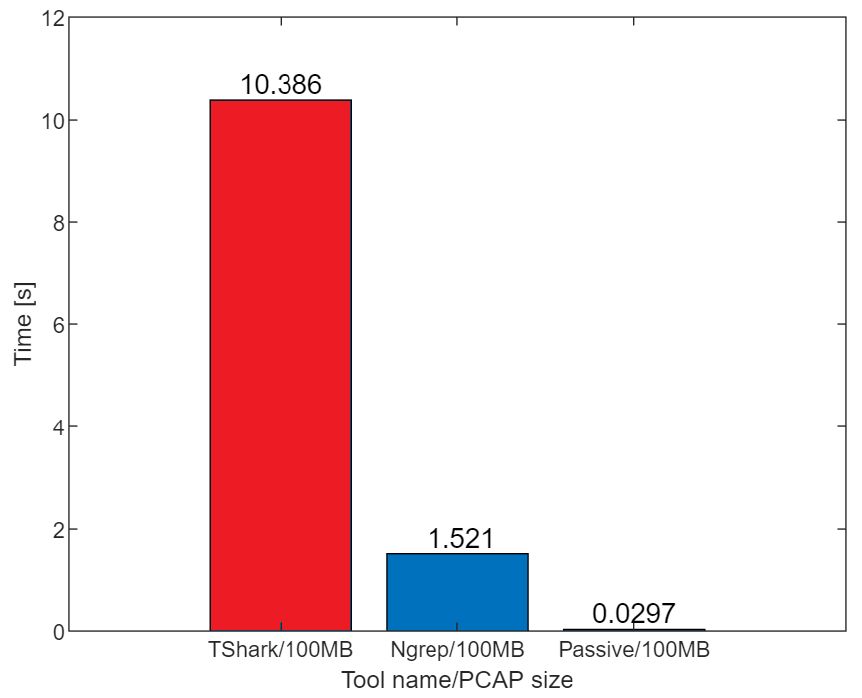
Figure 14. Comparison of the execution time for different tools and 100 MB PCAP